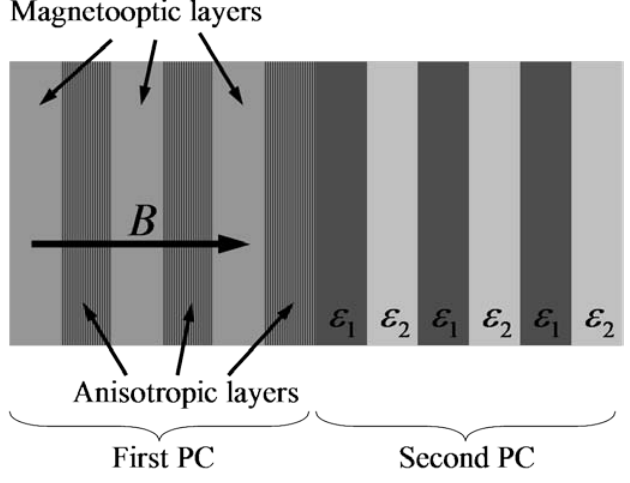
crystal ( and at zero magnetization). The unit cell of the second PC consists of two isotropic layers with